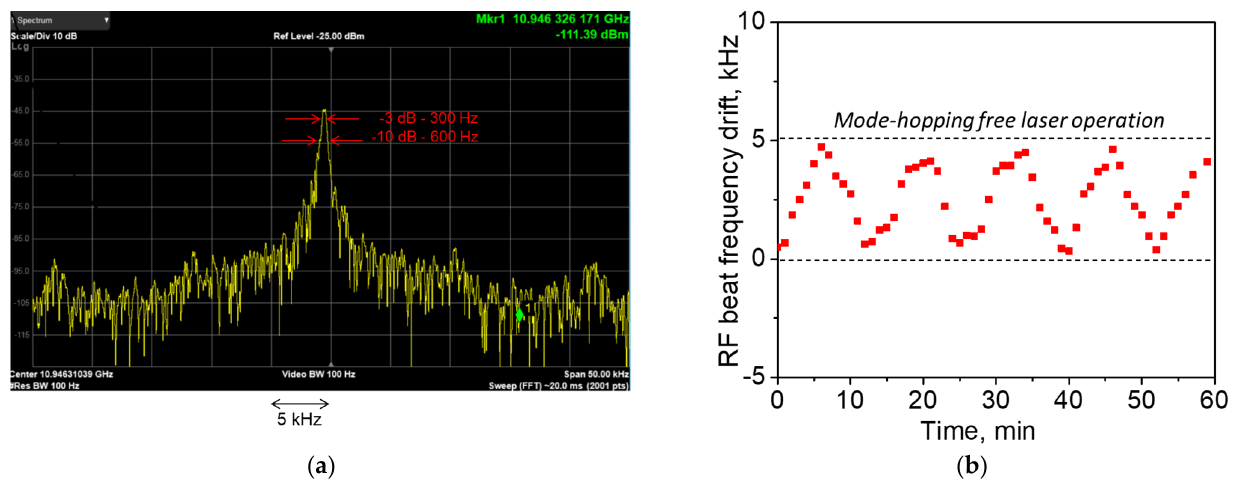
Figure 3. ( a ) Typical RF beat note spectrum measured with two master-oscillator outputs; ( b ) drift in the RF beat frequency measured each minute for 60 min.